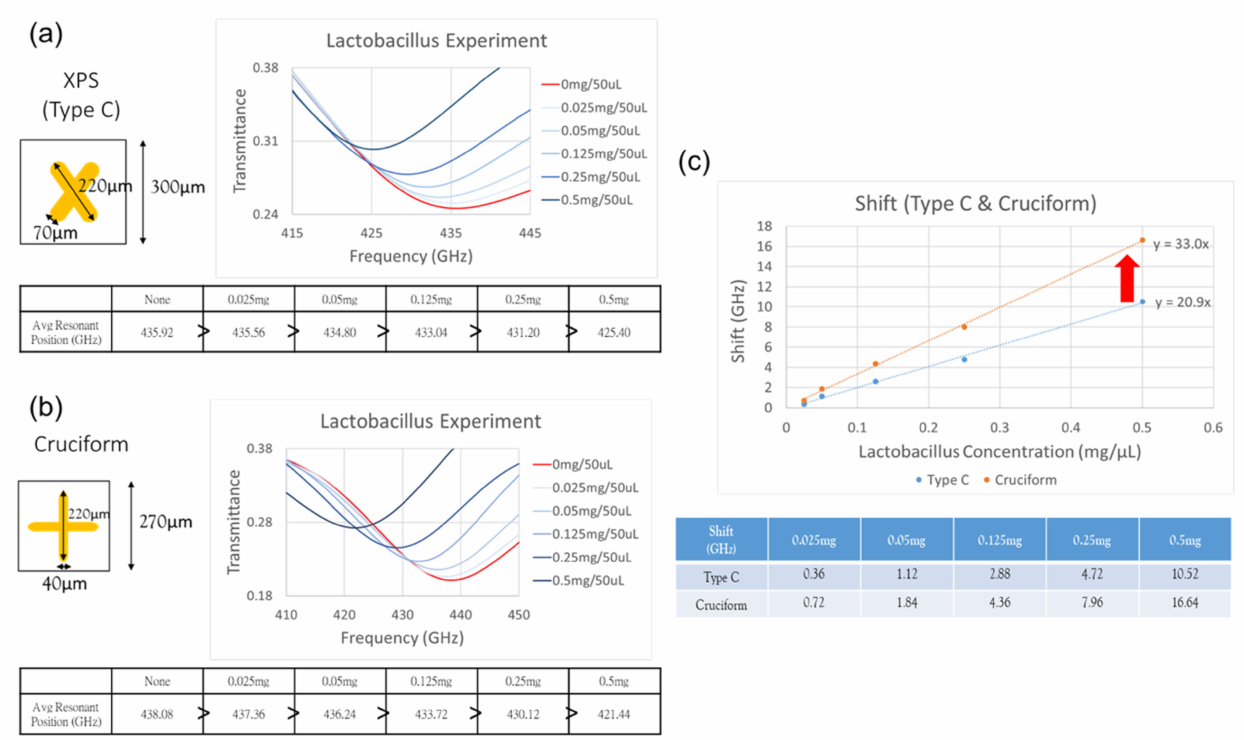
Figure 9. Probiotic measurement results of ( a ) Type C chip and ( b ) Cruciform chip. ( c ) Shift compari- son chart of Type C and Cruciform